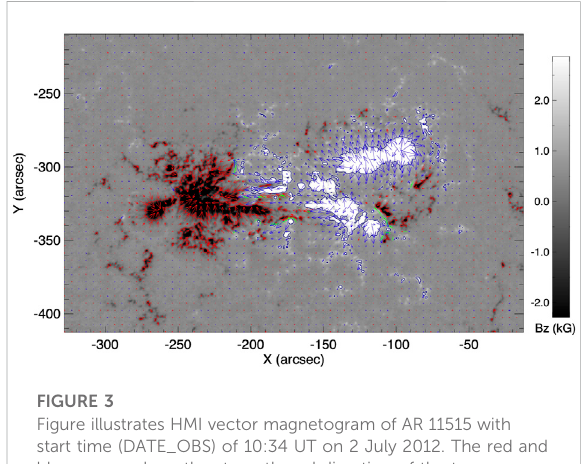
FIGURE 3 Figure illustrates HMI vector magnetogram of AR 11515 with start time (DATE_OBS) of 10:34 UT on 2 July 2012. The red and blue arrows show the strength and direction of the transverse magnetic fi eld, while green line mark